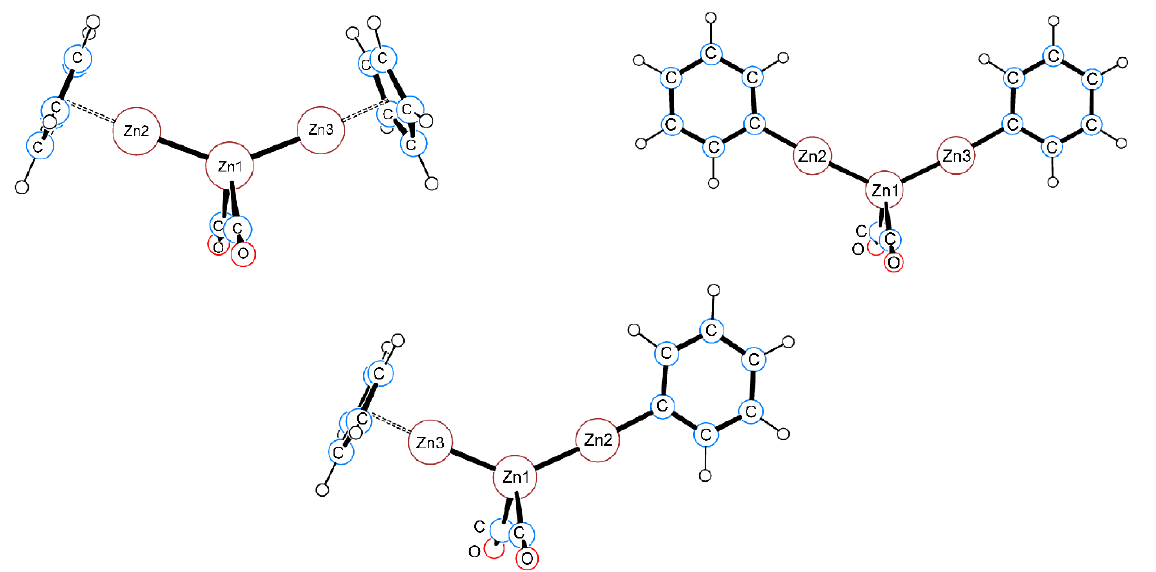
Figure 1. Optimized structures of complexes 1 – 3 , isolobally related to methane.